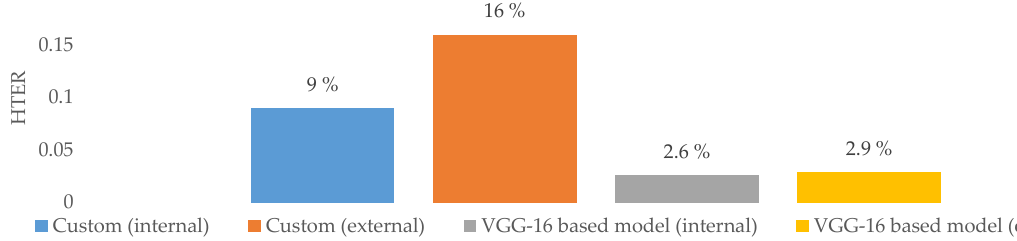
Figure 10. Performance evaluation of the custom model and transfer-learning-based model: HTER (the lower the better).